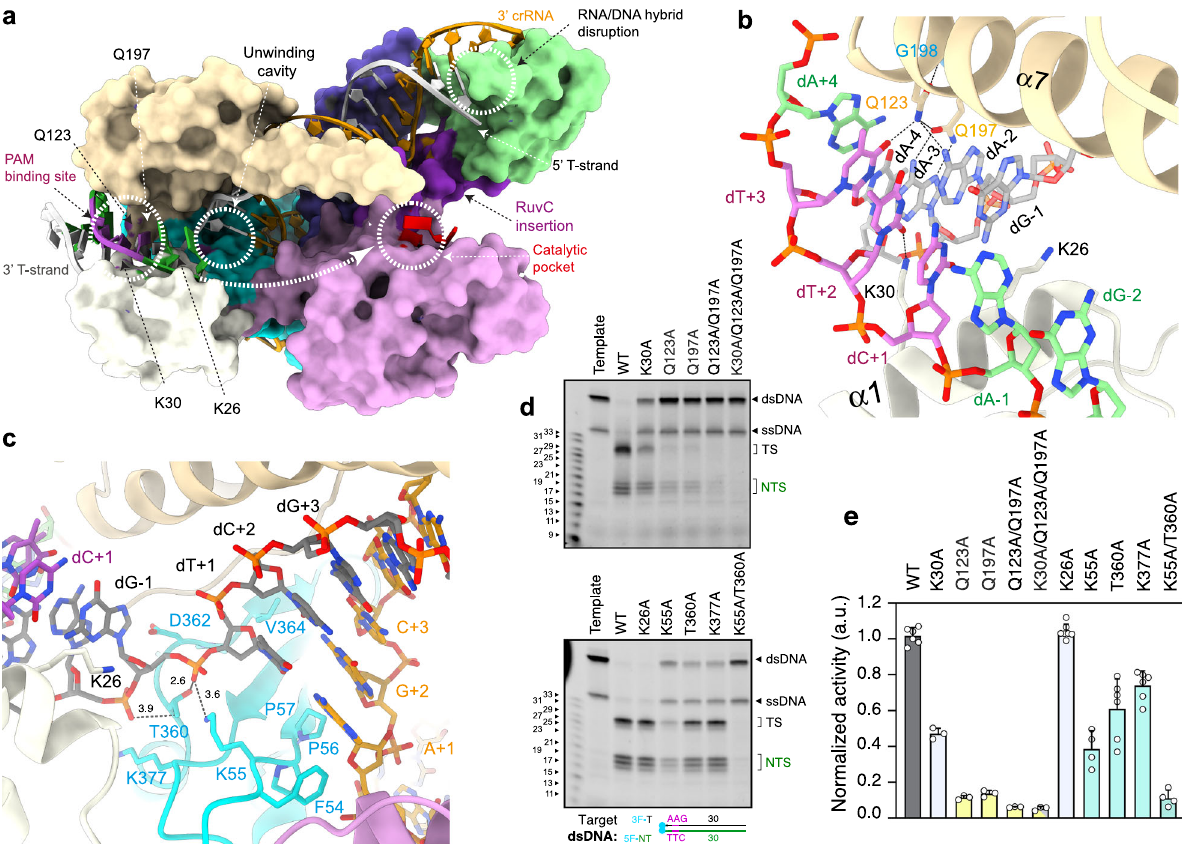
Fig. 4 Cas12j3 PAM recognition, uncoupling of the Watson – Crick dA-1:dT + 1 pair and unzipping. a Surface representation of Cass12j3 – R-loop complex. The white dashed arrow shows the predicted path of the NT-strand to the nuclease site after dG-2 (Supplementary Fig. 6). b Detailed view of the PAM nucleotides recognition and dsDNA unwinding depicting the conserved K26, K30, Q123, and Q197 residues (Supplementary Fig. 5c). c Zoom of the dT + 1/ dA-1 pair uncoupling, phosphate inversion and unzipping (Supplementary Fig. 5d). d dsDNA cleavage assays using Cas12j3 wild type and PAM unwinding, activation and catalytic mutants. Oligonucleotides 3F-T-AAG-30 and 5F-NT-TTC-30 were used as substrates (Supplementary Table II). T-strand (TS) and NT-strand (NTS) products are marked. DNA markers are shown in nucleotides. e Quanti fi cation of the activity based on the cleavage experiments as shown in d . Bars represent mean ± SD. n > 3 independent